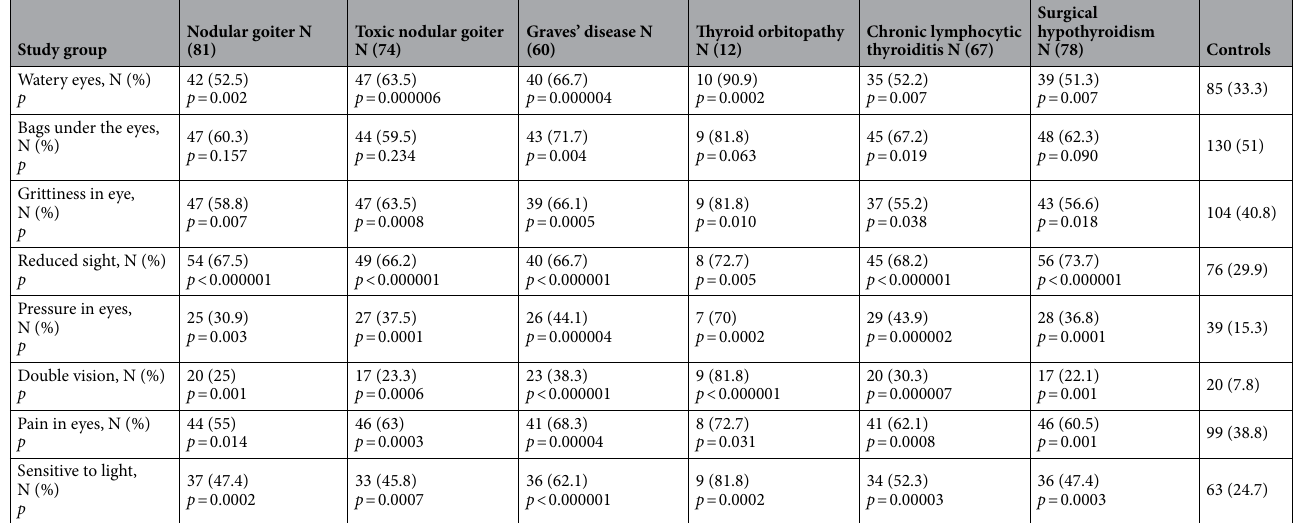
Table 4. Comparison of prevalence of particular ocular complaints between patients with thyroid disorders and healthy controls. N number of patients, p , p